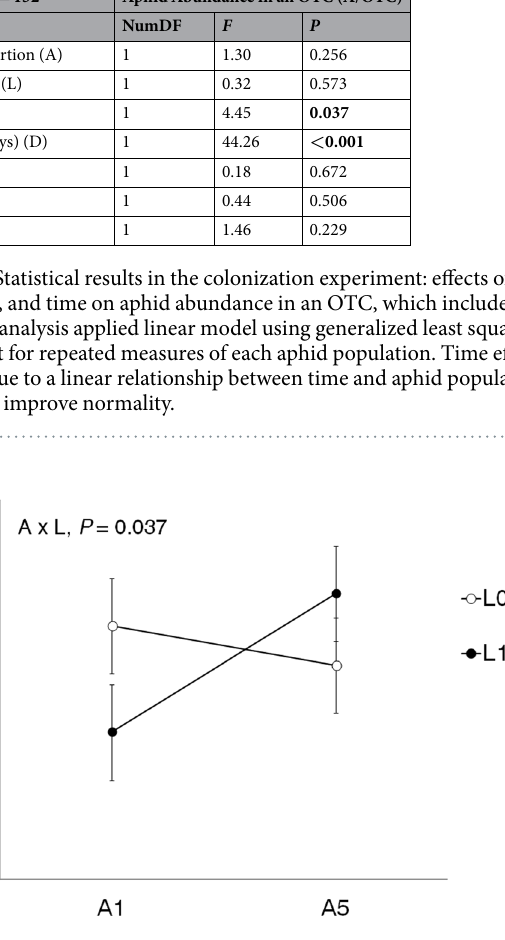
Figure 3. Alate proportion treatment (A) and lady beetle treatment (L) interacted and affected aphid populations in the colonization experiment (statistical results reported in Table 2). A1 = low alate proportion (1%, warming scenario); A5 = high alate proportion (5%, ambient-temperature scenario); L0 = lady beetle absence; L1 = lady beetle presence. Each point represents the average total aphid abundance per OTC (least square means ± SE) over the study